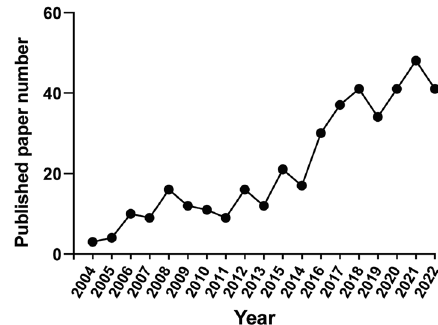
Fig. 2 The publications related to ucRNAs in recent years. The number of papers related to ucRNA research is presented since the discov- ery of the ultra-conserved region in 2004. As can be seen from the figure, the number of papers generally maintains an upward trend, which means that ucRNA is attracting more and more attention and is worthy of further